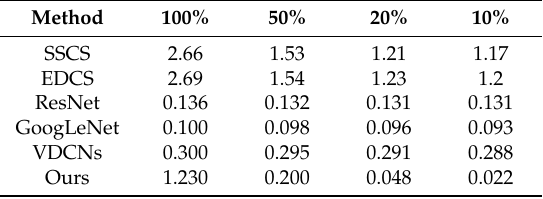
Table 8. Comparison of average runtime per image on Dataset 2 under different